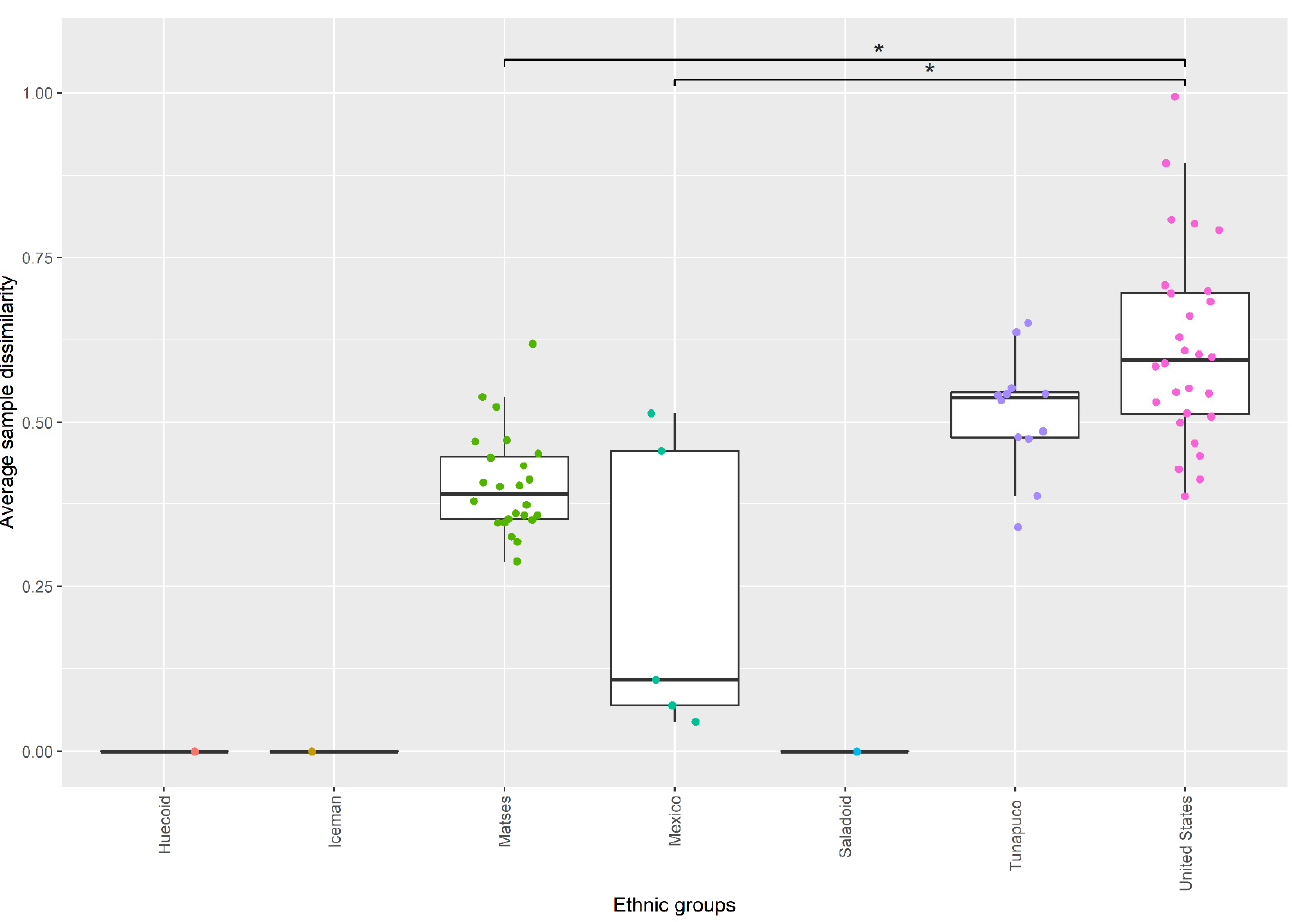
Figure 5. Mycobiome divergence across ethnic groups. Heterogeneity (inter-individual divergence) in community composition across the ethnic groups. Individual observations (dots) were colored according to ethnic group; * p < 0.05.